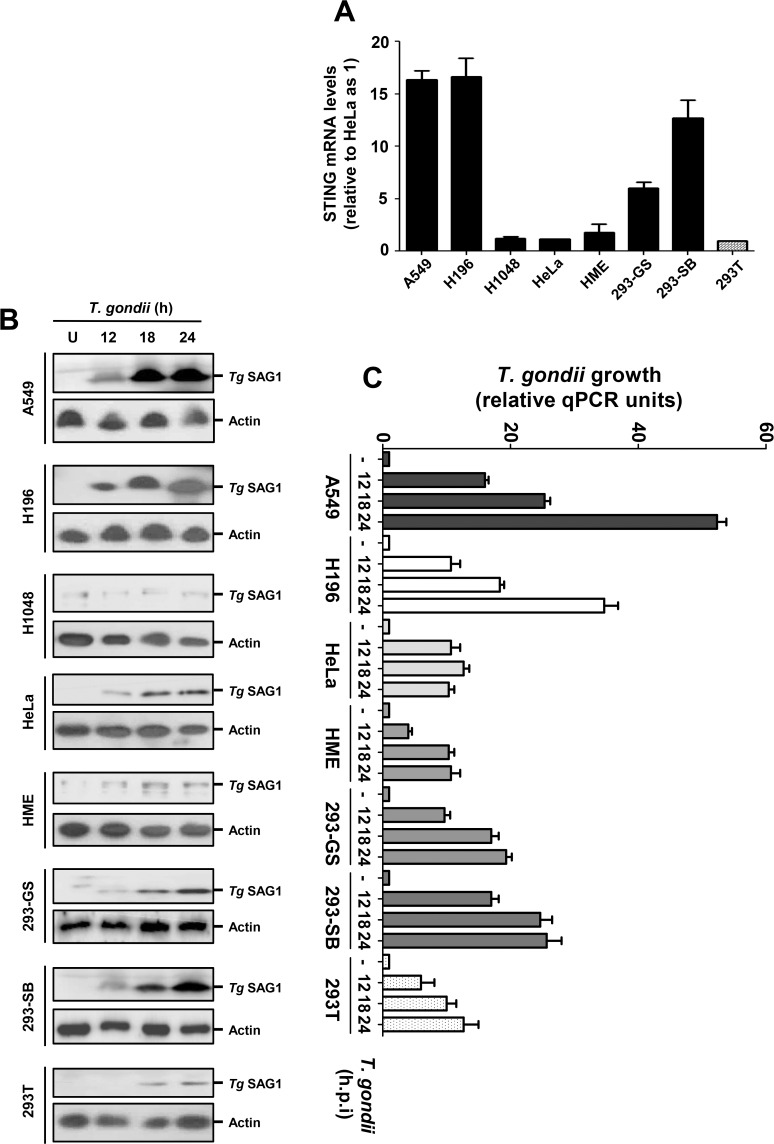
STING levels and T. gondii replication in selected human cells.
A, STING mRNA levels of the indicated cell lines, determined by qRT-PCR, were plotted. B/C,
T. gondii RH growth in cell lines of diverse STING levels, measured respectively by Tg SAG1 immunoblot (panel B, with actin as loading control) and by qPCR of parasite DNA (panel C).